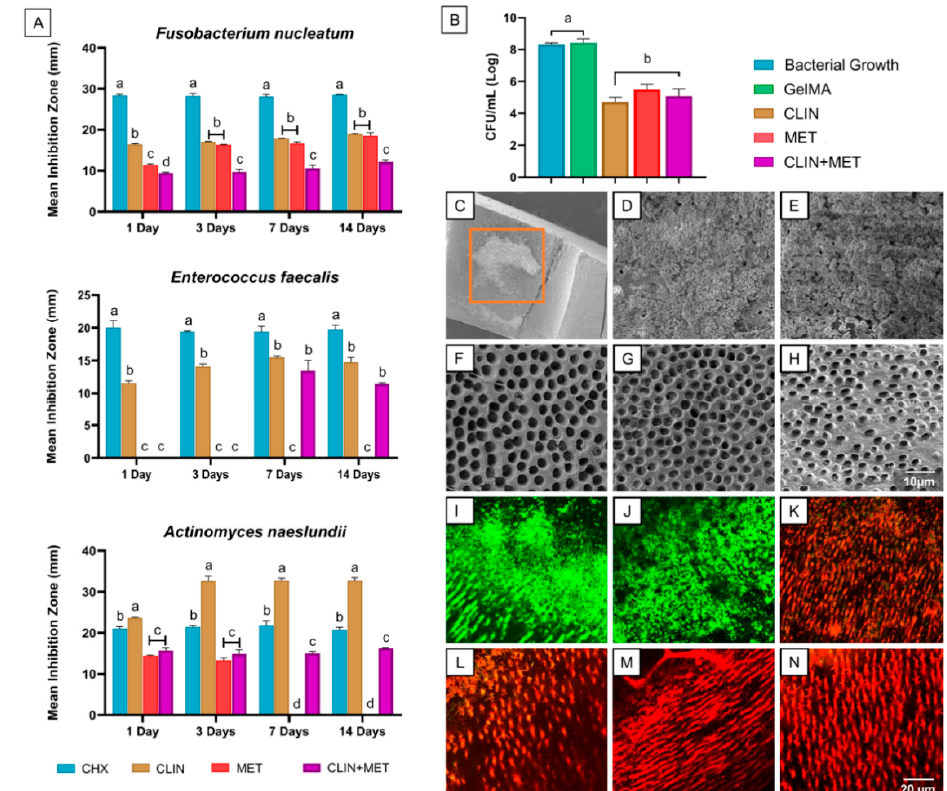
Figure 3. Results for the antimicrobial properties of the tested hydrogels. ( A ) Graphs showing the results (mean inhibition zones, in mm) from the agar diffusion assays against three bacteria at days 1, 3, 7, and 14. Chlorhexidine (CHX) served as the positive control. ( B ) Graph depicting the results (mean counts of colony-forming unit [CFU/mL]) from the A. naeslundii biofilm model used in the study, having a negative control group consisting of untreated bacterial growth. Distinct letters above the standard deviation bars indicate statistically significant differences among the groups ( p < 0.05). ( C ) Representative SEM micrograph showing the evaluated areas of each sample (inner root walls of dentin slices). ( D–H ) SEM micrographs for the negative control (D) and groups treated with GelMA (E), CLIN-based hydrogel (F), MET-based hydrogel (G), and CLIN+MET-based hydrogel (H). ( I–N ) CLSM micrographs of 7-day A. naeslundii biofilm imaged from inner root canal walls. Images are related to the negative control group (I), antibiotic-free GelMA (J), CLIN-based hydrogel (K), MET-based hydrogel (L), CLIN+MET-based hydrogel (M), and 2.5% sodium hypochlorite (N), which served as the positive control. CLSM images were collected in sequential illumination mode by using 488 nm and 552 nm laser lines. Fluorescent emission was collected in 2 HyD spectral detectors with filter range set up to 500–550 nm and 590–655 nm for green (SYTO9) and red dye (PI), respectively. SEM, Scanning Electron Microscope; GelMA, gelatin methacryloyl hydrogel; CLIN, Clindamycin; MET, metronidazole; CLSM, confocal laser scanning microscopy.